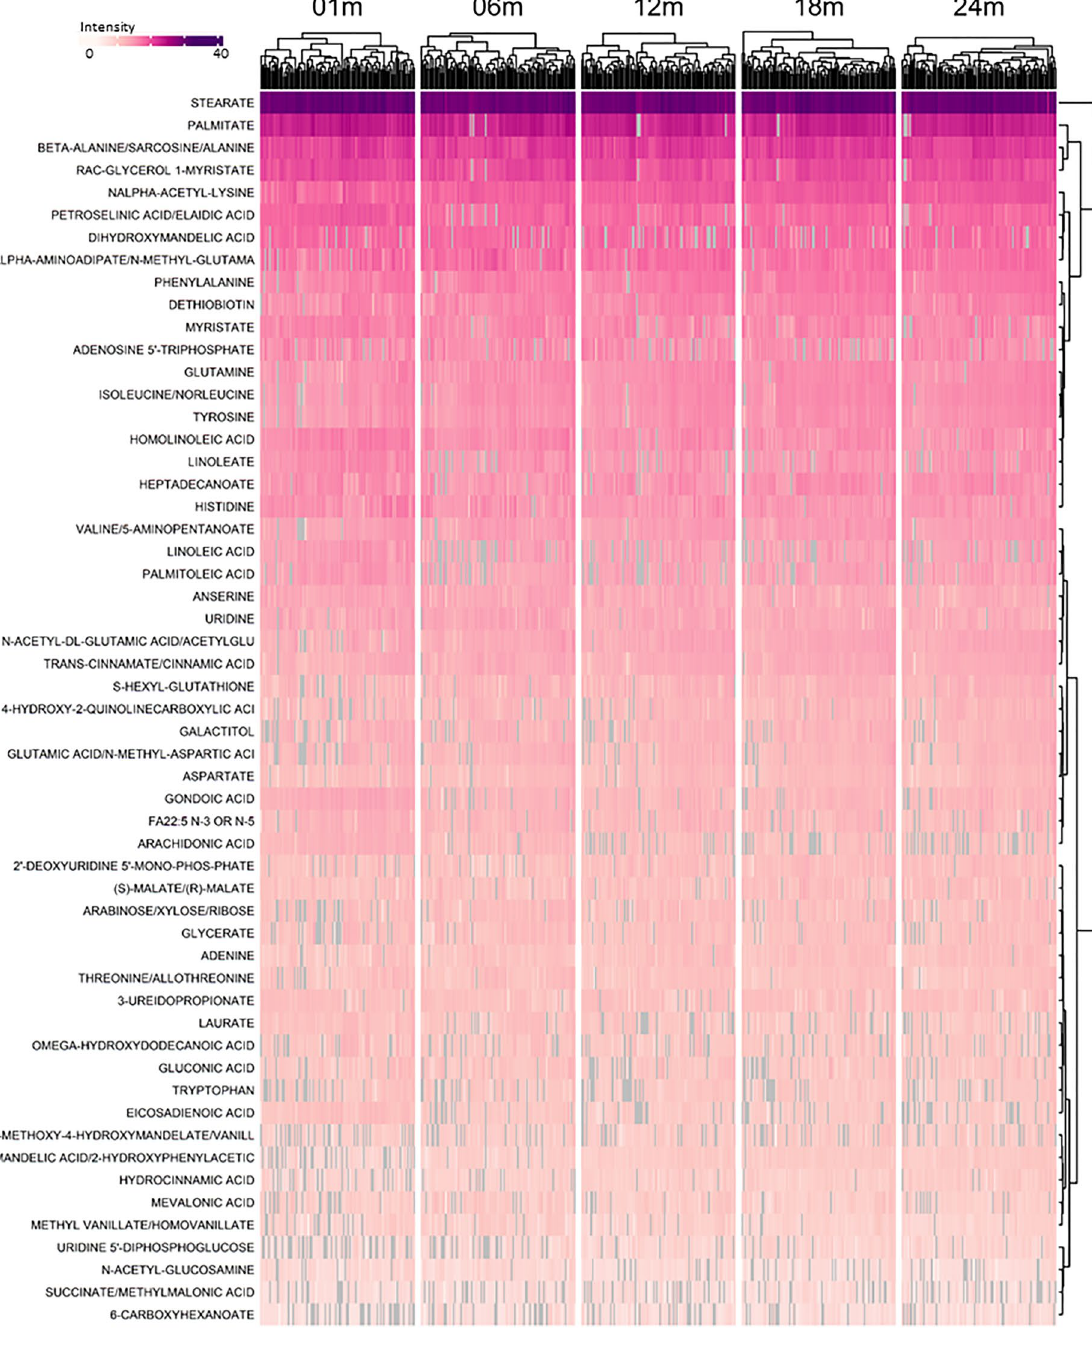
system development 2 , asthma and allergy 3–5 , obesity and growth 6–9 , and cognitive development 10 . At least 50% prevalence at each timepoint was observed for about 200 confirmed metabolites, indicating that the fecal metabo- lome was relatively stable. Variability was primarily explained by the individual providing the sample as well